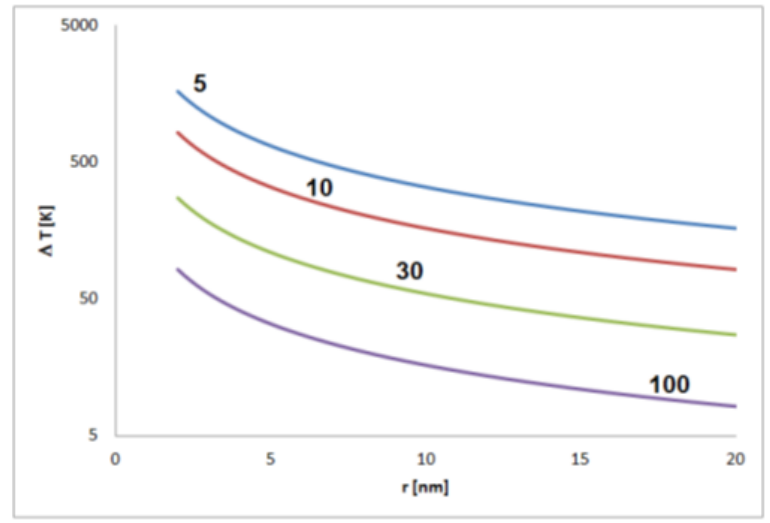
Figure 4. Estimated temperature differences T corresponding to the thermal energy equal to the electrostatic energy of a pair of elementary charges in distance r (for permittivity of 5, 10, 30 and 100).